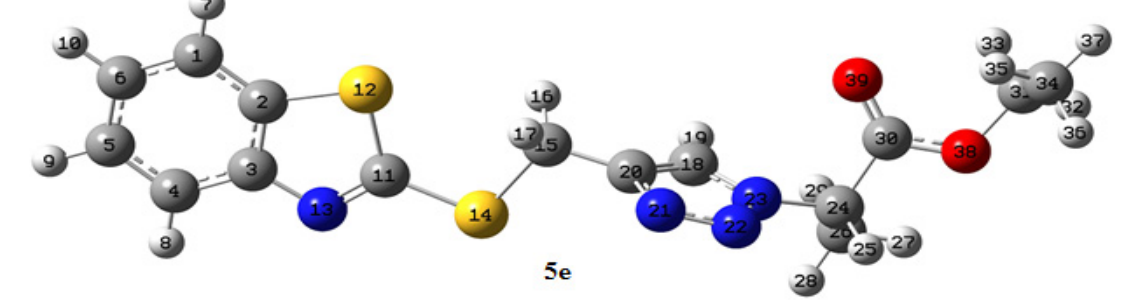
Figure 1. B3LYP/6-31 + G(d, p ) optimized geometry of 5e in DMSO. The calculated 1 H and 13 C chemical shifts are in excellent agreement with the ex-